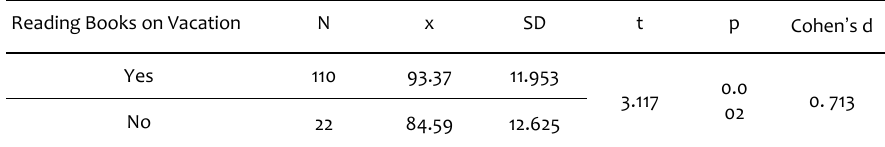
Table 7. Students' reading motivation scores in relation to reading books on